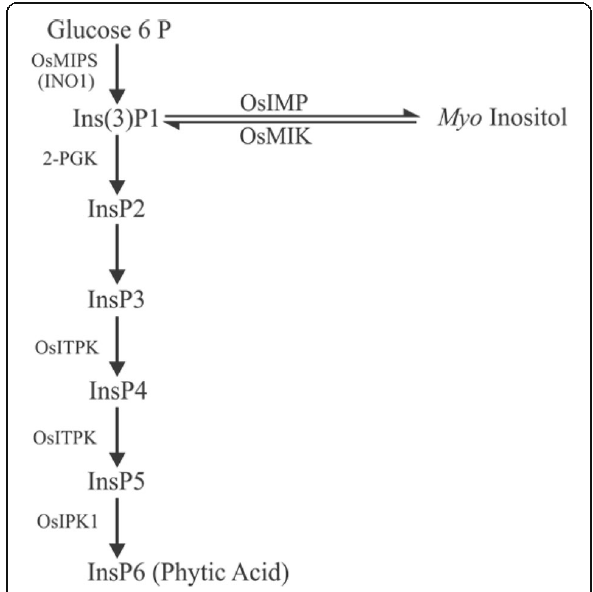
Fig. 2 Schematic diagram of the lipid-independent PA biosynthetic pathway in rice seeds. Genes involved in the steps of PA biosynthesis are illustrated